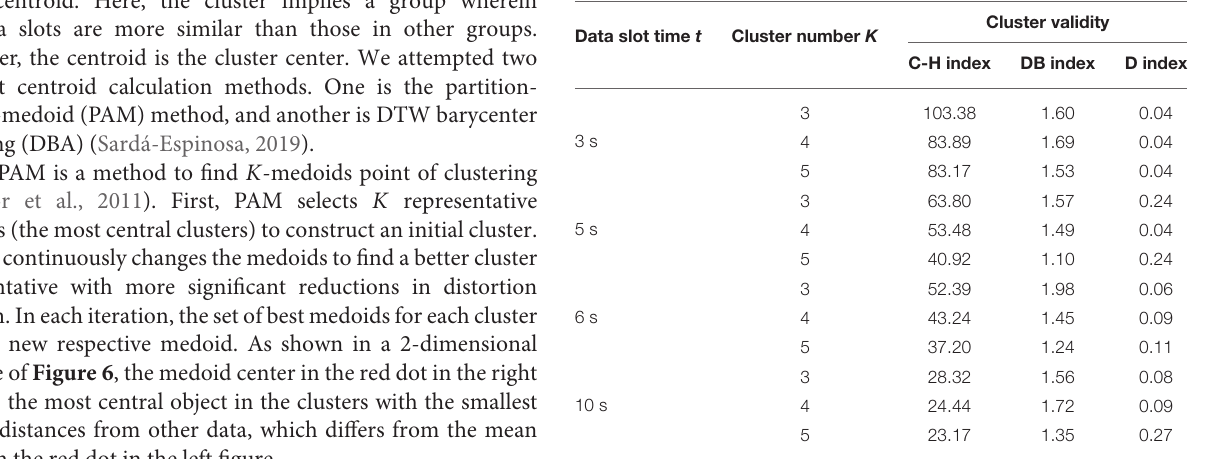
TABLE 3 | DTW-DBA result.